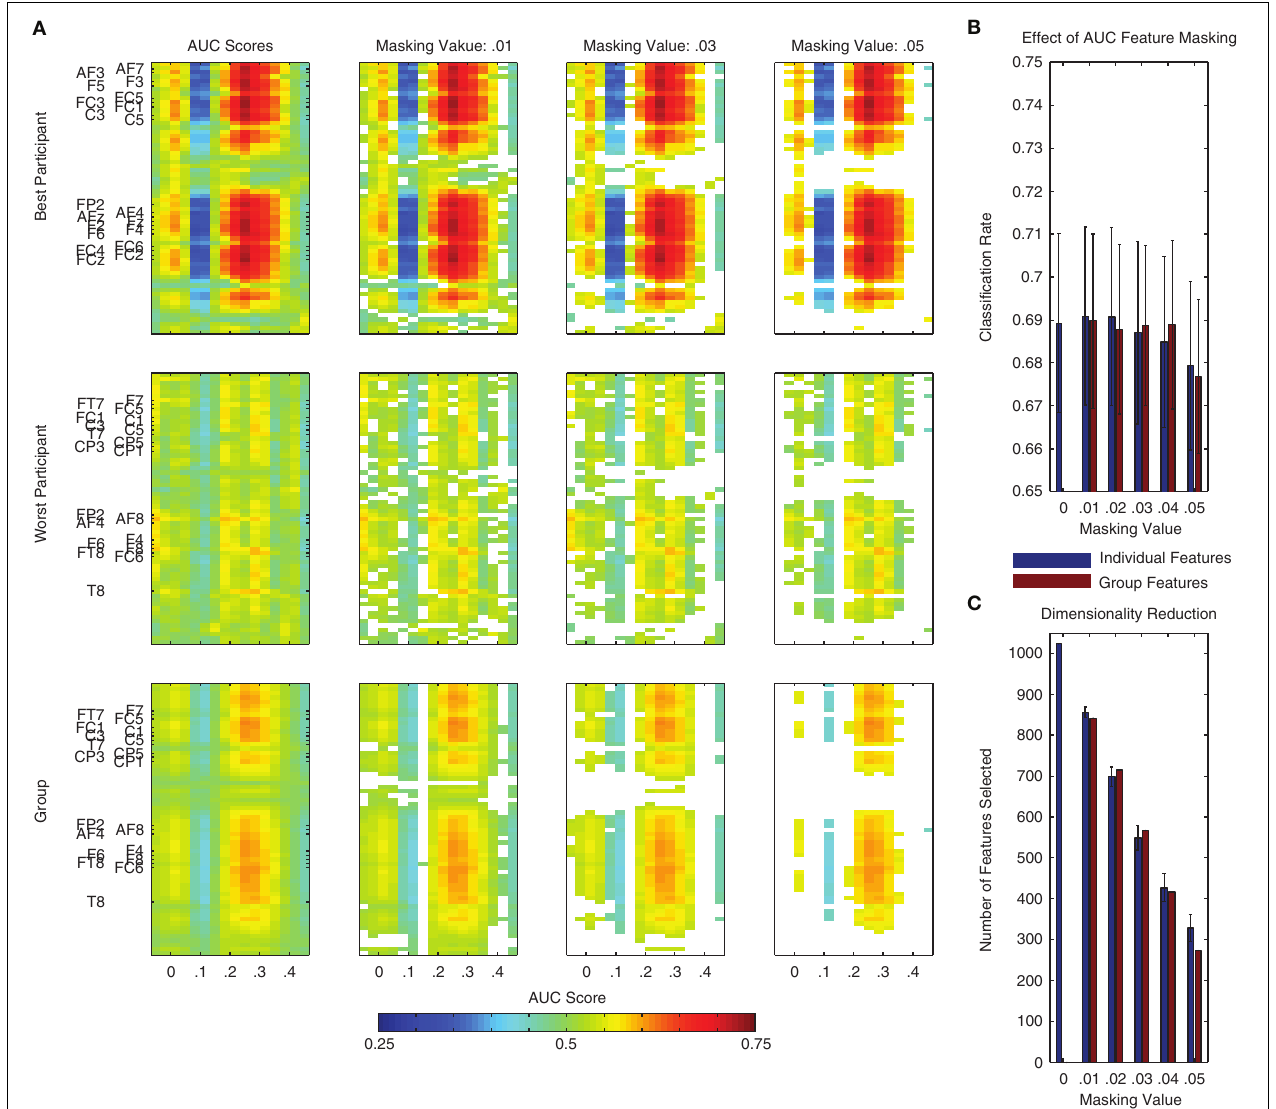
FIGURE 8 | Area under the receiver operating curve (AUC) scores and masking procedure. AUC scores are often used to evaluate the class-relevant information present in datasets used for classifier training. Additionally, they can be used to select the most relevant dimensions of the data during classification analysis. (A) Such a procedure is illustrated here using the same two individual participants as in Figure 7 as well as using all participant data from Dataset 1. Individual dimensions were selectively masked (i.e., removed from the dataset) on the basis of their AUC score. This masking value was defined as | AUC − 0 . 5 | , that is, the absolute value of the AUC Score minus 0.5. This is effectively a measure of a feature’s distance